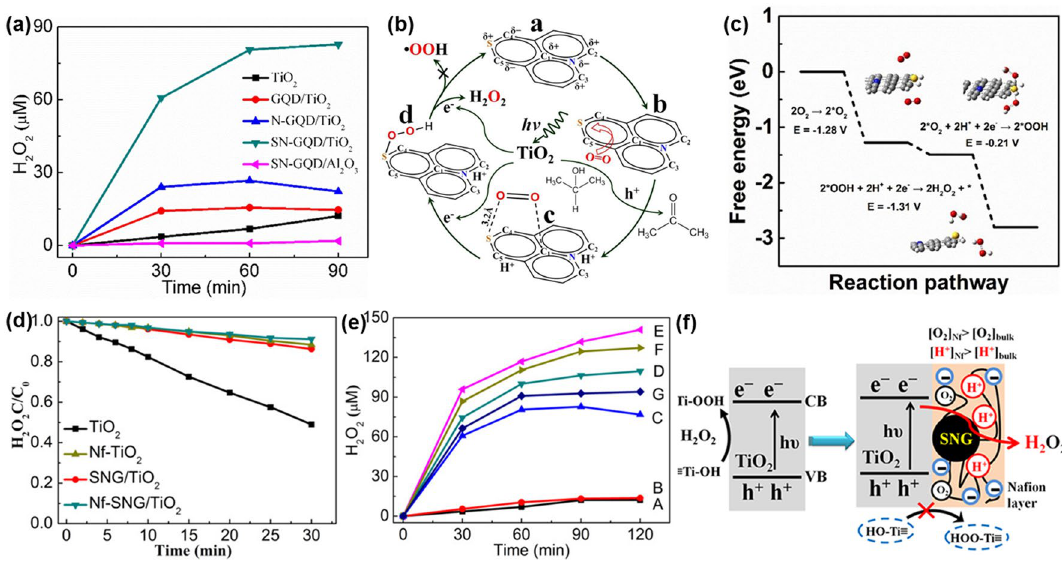
Fig. 8 a Photocatalytic H 2 O 2 generation on the catalysts. b Proposed mechanism of photocatalytic H 2 O 2 formation over the SN-GQD/TiO 2 pho- tocatalyst. c Free energy diagrams of reaction pathways. Reproduced with permission from Ref. [143]. Copyright 2018 Elsevier. d Photocatalytic decomposition and e production of H 2 O 2 on different catalysts under visible light. f Photocatalytic reaction mechanism for H 2 O 2 formation on the Nf-SNG/TiO 2 photocatalyst. Reproduced with permission from Ref. [144]. Copyright 2019 American Chemical